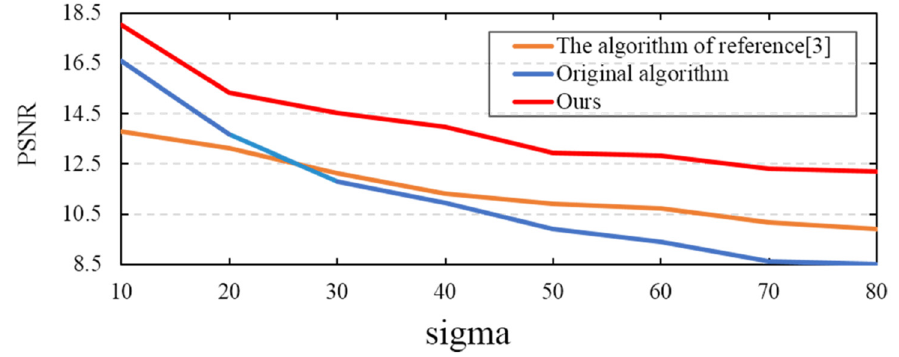
Figure 7. PSNR line chart of the three algorithms for the Monarch image.